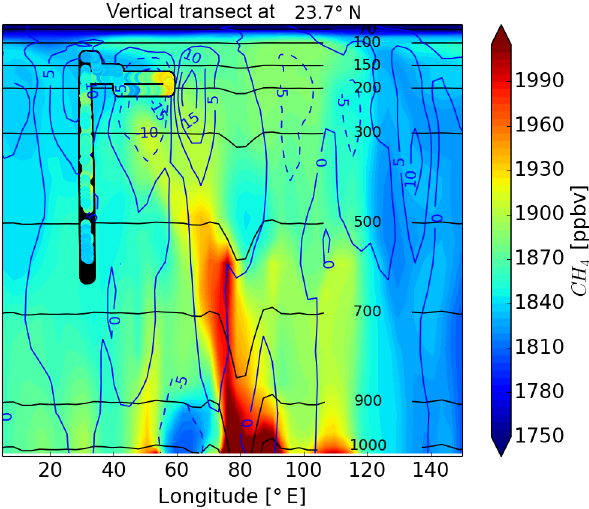
Figure 9. EMAC modelled CH 4 ; daily mean transect along 23.7 ◦ N, and measured CH 4 along the aircraft track for flight 19. Additional EMAC pressure (black lines in hPa) and EMAC northward wind component (blue lines in ms − 1 ; southward wind dashed lines).